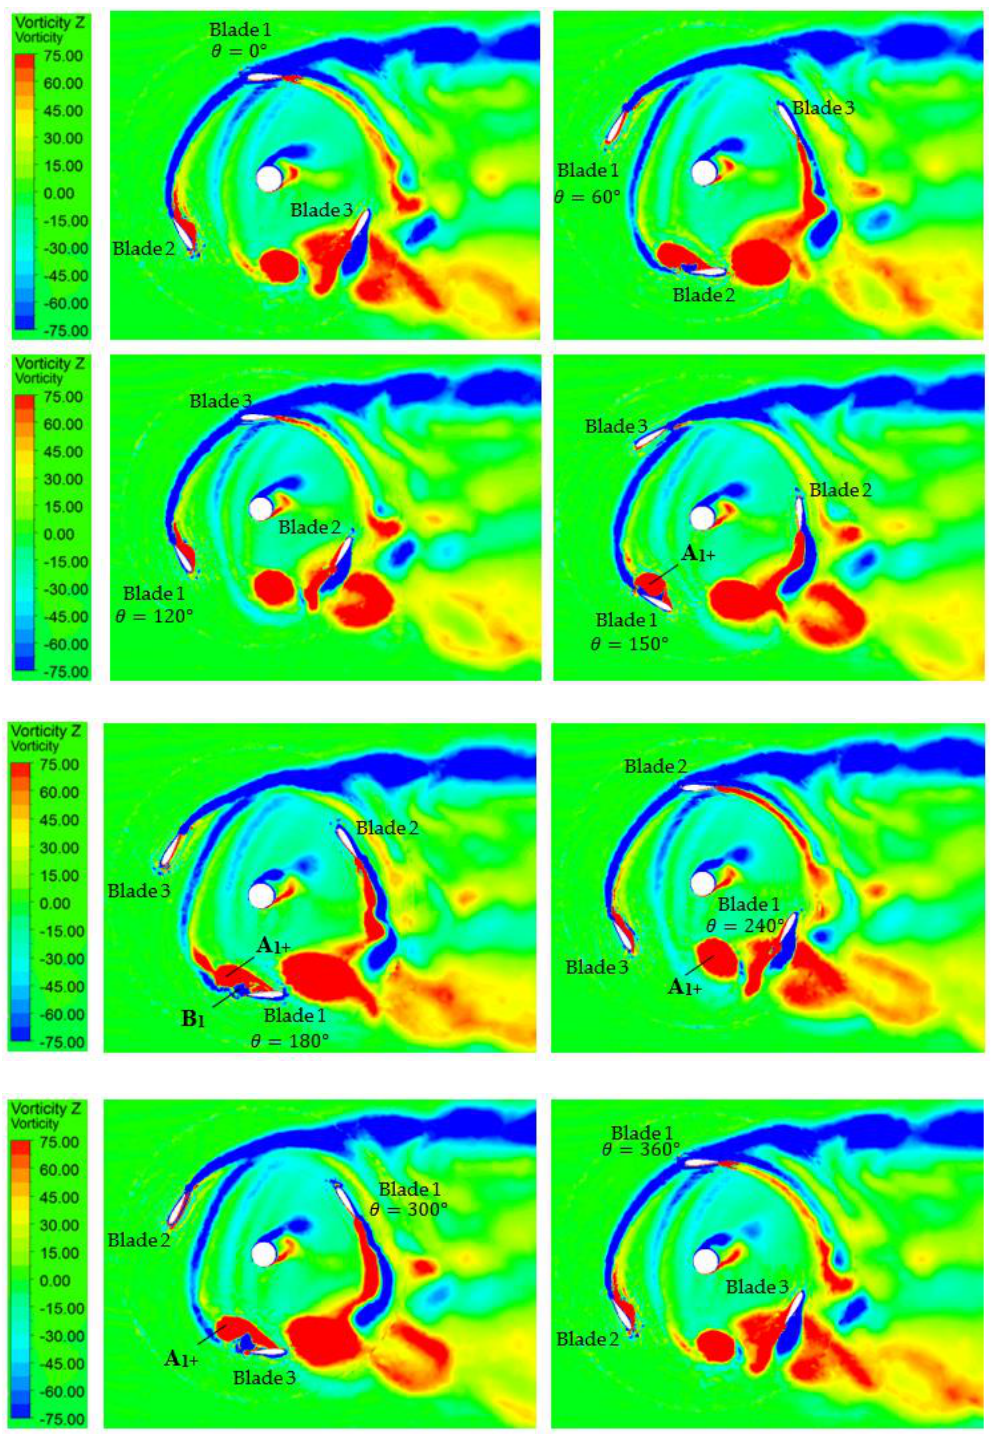
Figure 12. Instantaneous vorticity field on the symmetry plane for the URANS model, at λ = 2, showing different azimuthal angles. Between an azimuthal angle of θ = 0° and θ = 80°, the flow is attached but at θ = 90° the flow separation from the leading edge of the blade starts. As the turbine rotates, an initial vortex is